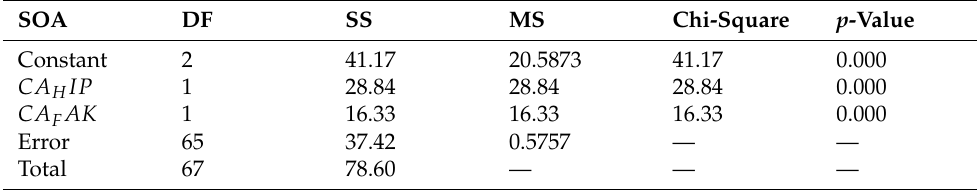
Table 6. The results of the analysis of variance (ANOVA).